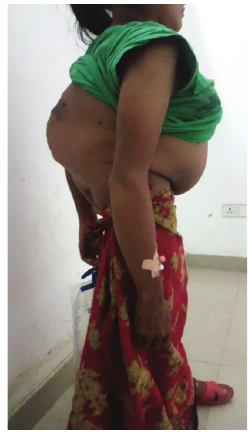
Figure1:Clinicalphotographshowinglargegibbusoverlowerback. Figure 2: Clinical photograph showing multiple healed sinuses over